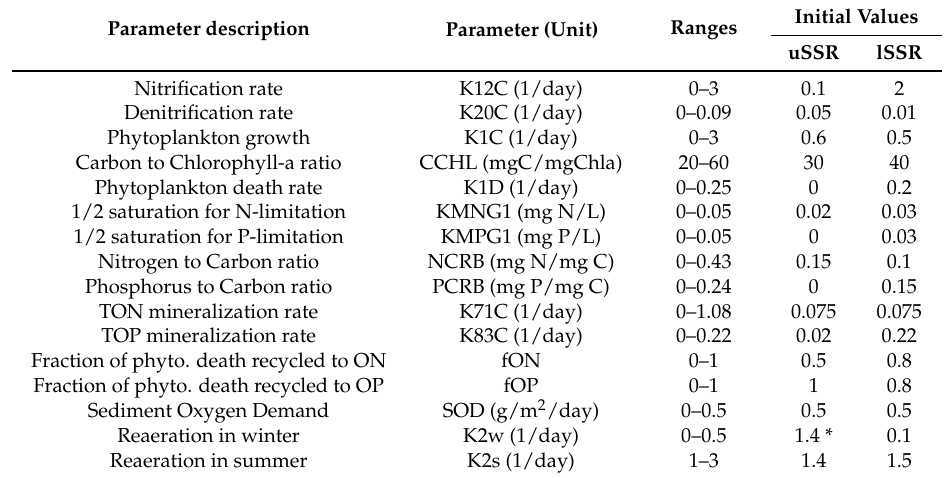
Table 1. Selected parameters for sensitivity